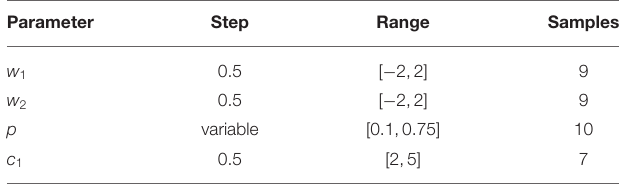
2 and 2 standard −